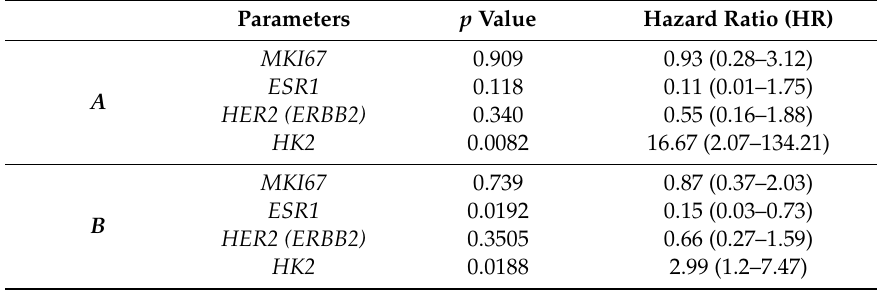
Figure 8. Enhanced HK2 expression levels identify a subset of poor prognosis tumors. Kaplan–Meier analysis of overall survival ( A ) and relapse free survival ( B ) of a curated cohort of ER + / HER2 + patients divided into high- and low-expressing, as described in Method Details, for HK2 expression. The hazard ratio (HR), interval of confidence and log-rank Mantel–Cox p value are shown. Table 1. Multivariate Cox regression analysis (overall survival (OS), A) and (relapse-free survival (RFS),